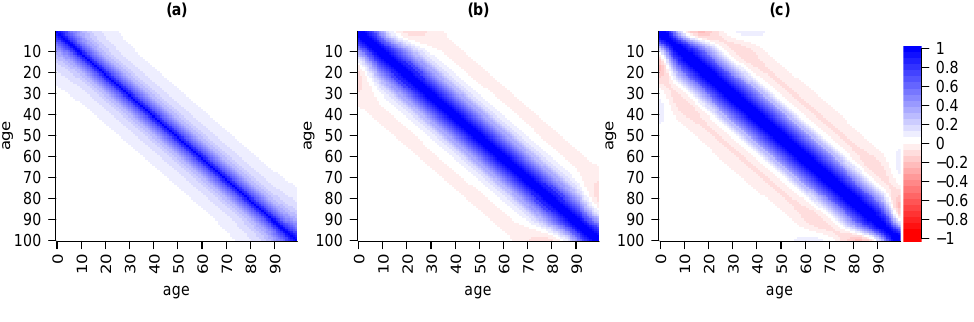
Figure 2. Correlation structure of Gaussian priors with penalisation for deviation from ordinate with ε = 1/100 in subfigure ( a ), straight line with ε = 1/2000 in subfigure ( b ), and parabola ε = 1/50000 in subfigure ( c